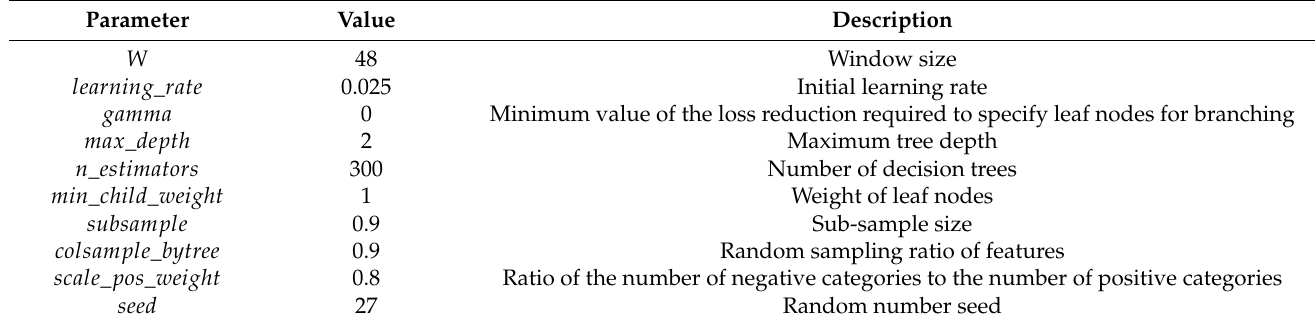
Table 2. Parameter setting of Window-based XGBoost